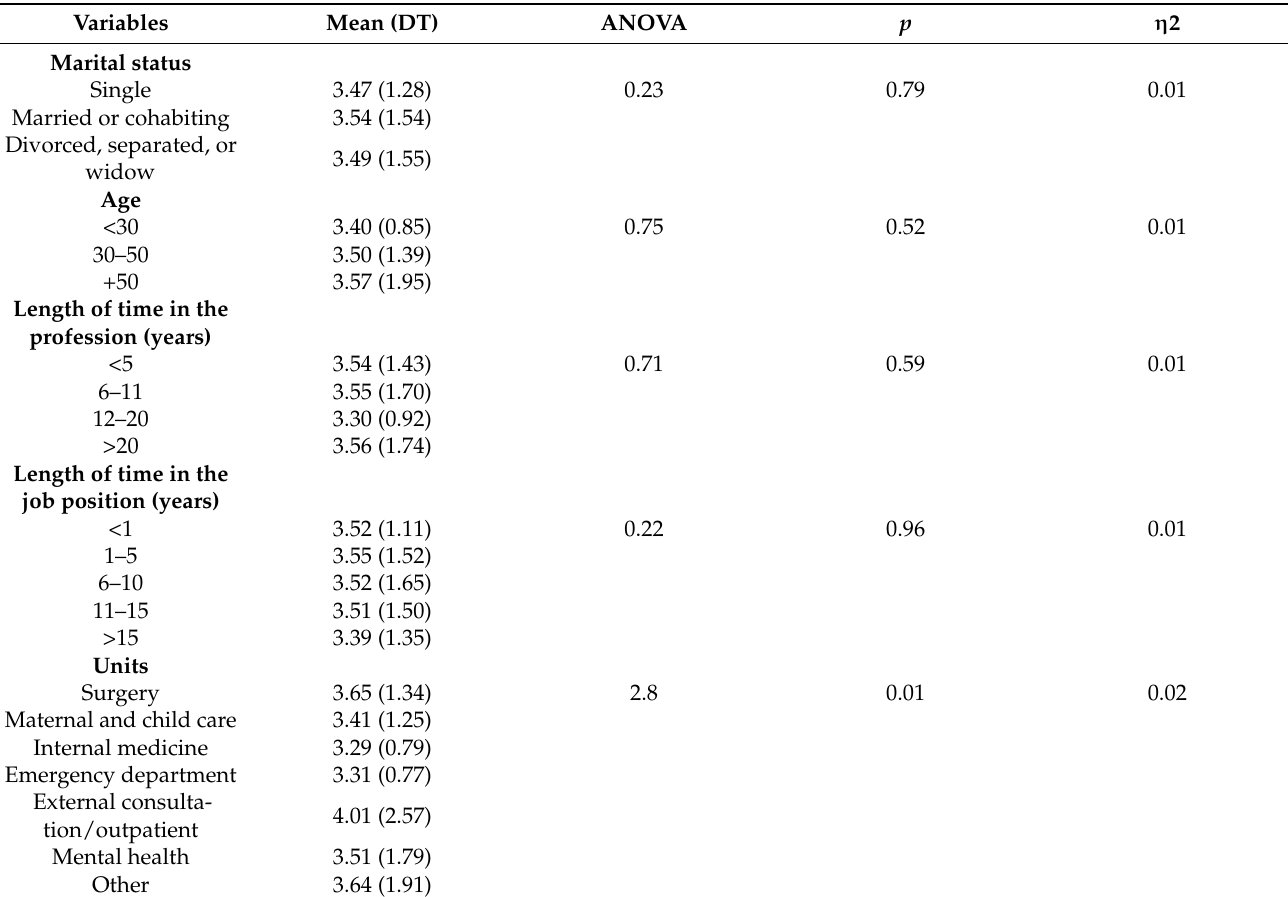
Table 7. ANOVA for work-related lateral